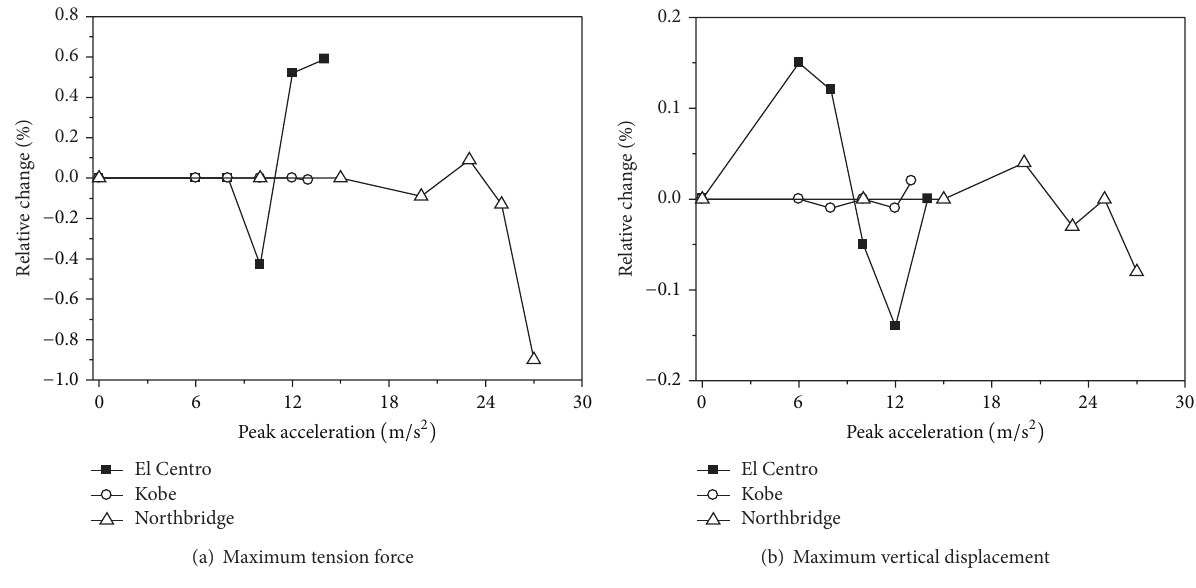
Figure 6: Relative changes of the conductor’s maximum responses.